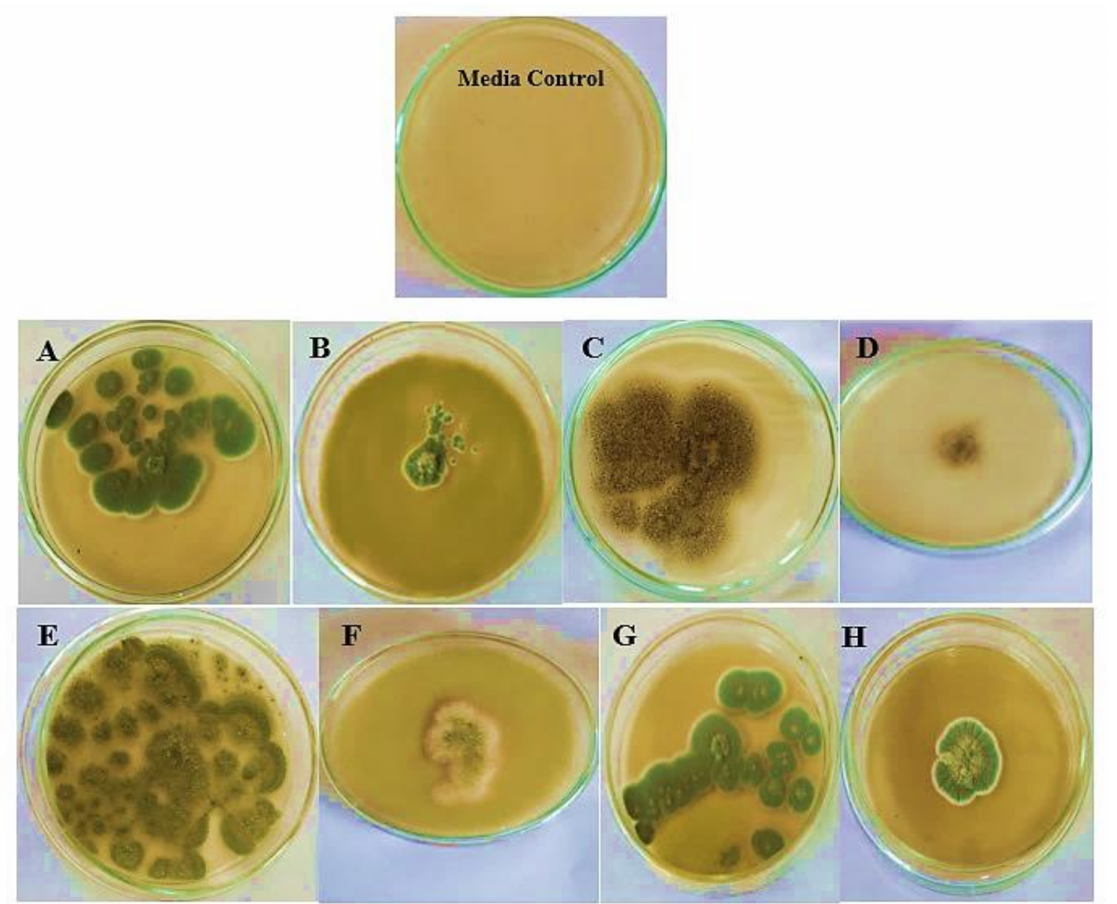
Figure 4. Antifungal potential of kefir extract (100 mg/mL) against selected pathogenic fungal strains: ( A ): Aspergillus fumigatus control, ( B ): Aspergillus fumigatus + kefir extract, ( C ): Aspergillus brasiliensis control, ( D ): Aspergillus brasiliensis + kefir extract, ( E ): Aspergillus flavus control, ( F ): Aspergillus flavus + kefir extract, ( G ): Penicillium expansum control, ( H ): Penicillium expansum + kefir